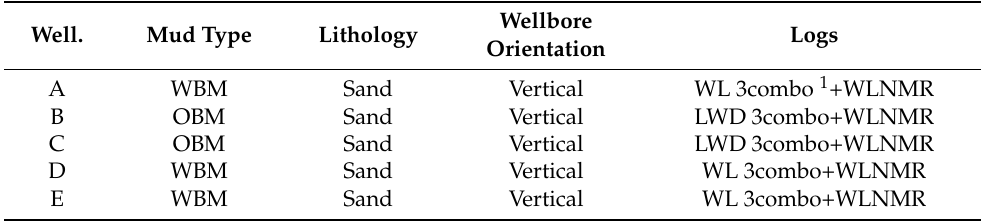
Table 3. Summary of the wells logging information. Well.